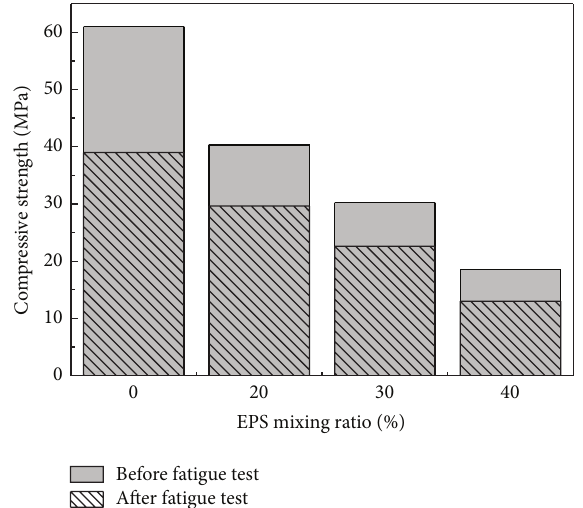
Figure 11: Later strength of 60KN 50000-time cyclic loading.